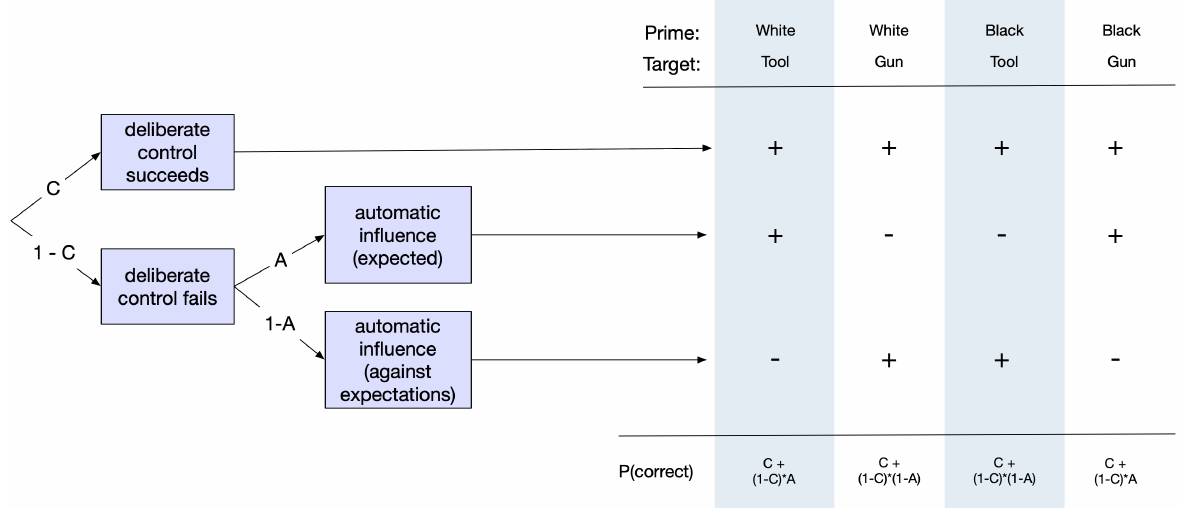
Figure 1: Process dissociation model (deliberation dominant) from Bishara and Payne (2009). Notes: Experimental conditions are shown in columns. Correct responses are indicated with a plus sign (+). Equations for the MPT model are shown at the bottom of each